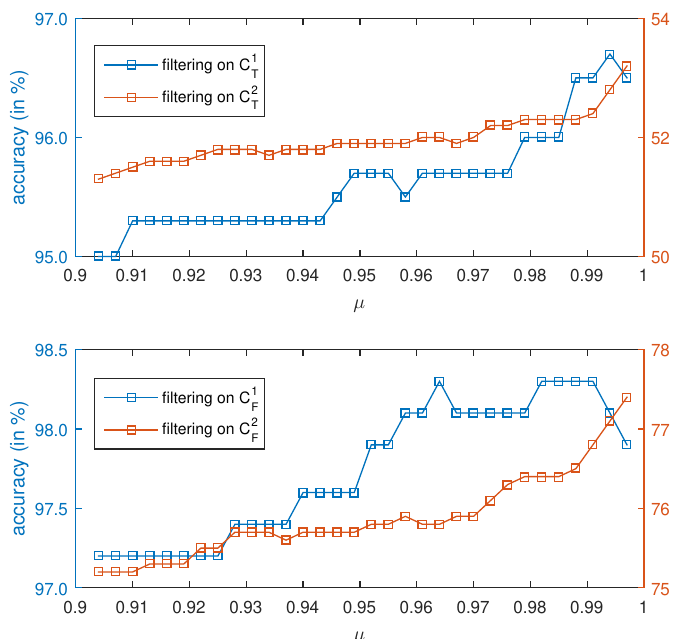
Figure 9. Accuracies of filtering results with different µ . The upper figure is for time domain, while the lower one for frequency domain.